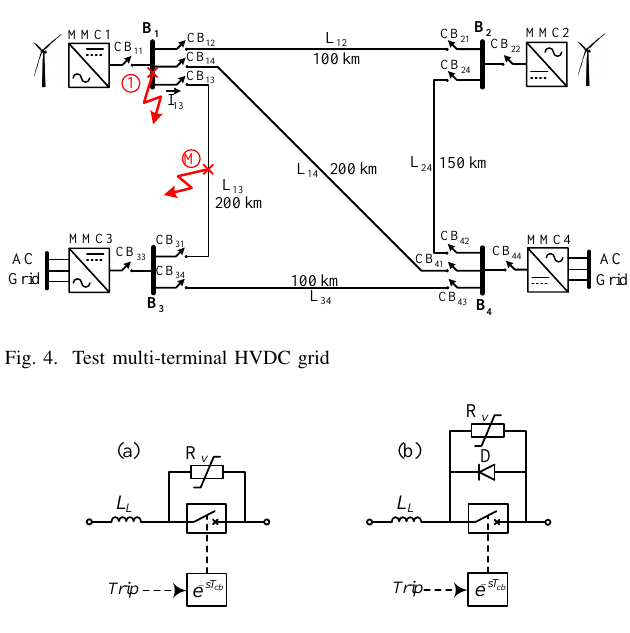
Fig. 5. Aggregated models (a) typical HCB, (b)